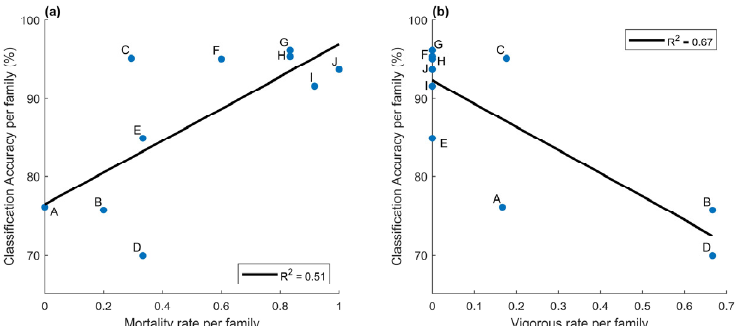
Figure 5. Correlation for ( a ) mortality rate and classification accuracy, and ( b ) vigorous rate and classification accuracy. Each data point represents a family indicated with the letter label.